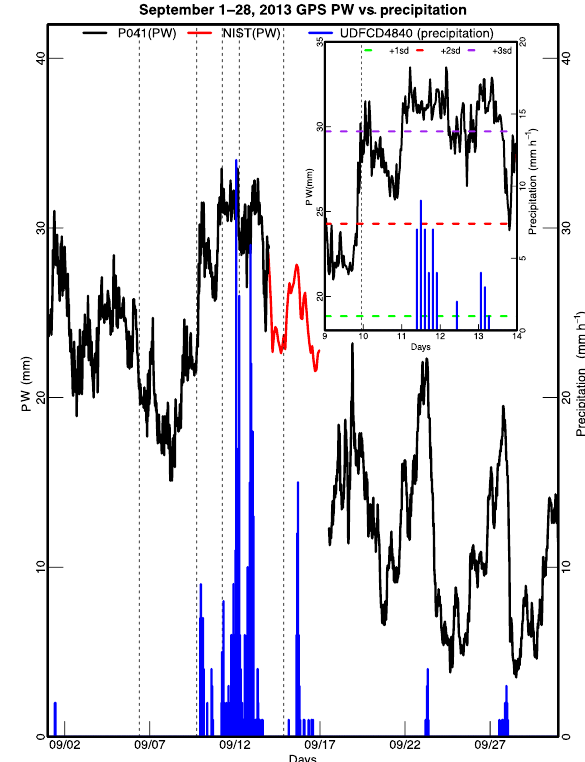
Figure 3. A time series of 30min (station P041) and 2-hourly (sta- tion NIST) GPS PW compared with precipitation (rain gauge UD- FCD4840) from 1 to 28 September 2013. The inserted graph com- pares the same variables from 9 to 14 September 2013 with the ad- dition of green, blue, and red horizontal dashed lines indicating 1, 2, and 3 standard deviations above the PW long-term median, re-